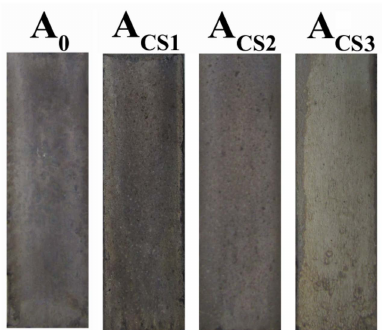
Figure 1. Optical images of the electrodeposited coatings.